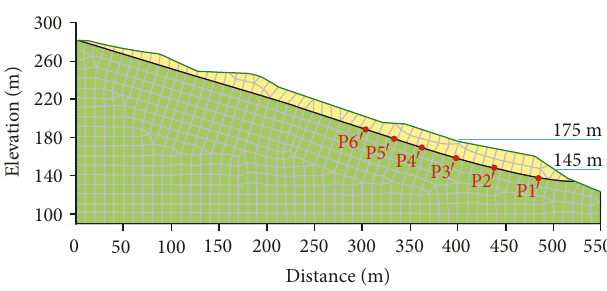
Figure 11: Numerical model of the Majiagou landslide.